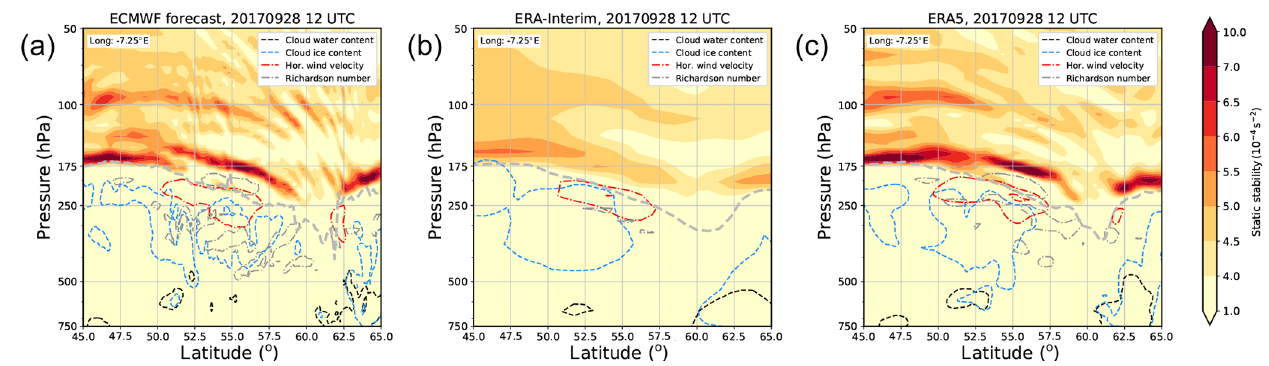
Figure 15. Zonal cross sections along − 7 . 25 ◦ E on 28 September 2017 at 12:00UTC show static stability (color shaded), the altitude of the 2pvu isosurface (light gray), cloud water content (black), cloud ice content (blue), horizontal wind speed (red), and Richardson number (dark gray). The three panels show (a) the ECMWF forecast (with 0.07 ◦ horizontal grid spacing and ∼ 300m vertical grid point spacing in the UTLS), (b) the ERA-Interim reanalysis (with 0.75 ◦ horizontal grid spacing and ∼ 1000m vertical grid spacing), and (c) the ERA5 reanalysis (with 0.25 ◦ horizontal grid spacing and ∼ 300m vertical grid